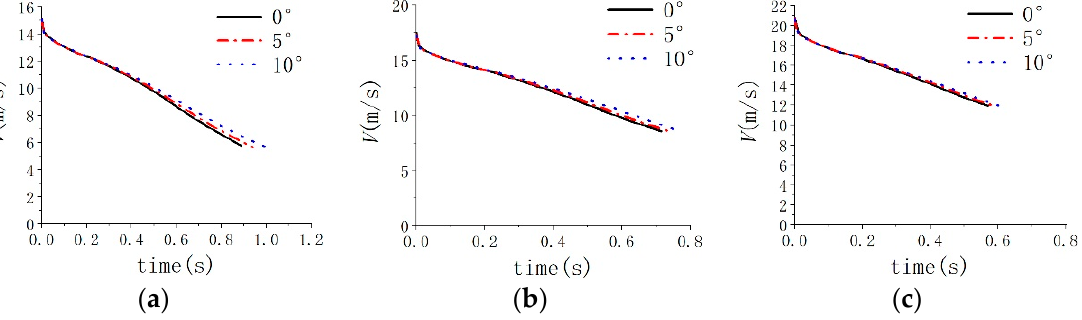
Figure 10. Images of axial velocity variation of vehicle under different initial angles. ( a ) Axial velocity of vehicle in case 1, 2, 3. ( b ) Axial velocity of vehicle in case 4, 5, 6. ( c ) Axial velocity of vehicle in case 7, 8, 9.